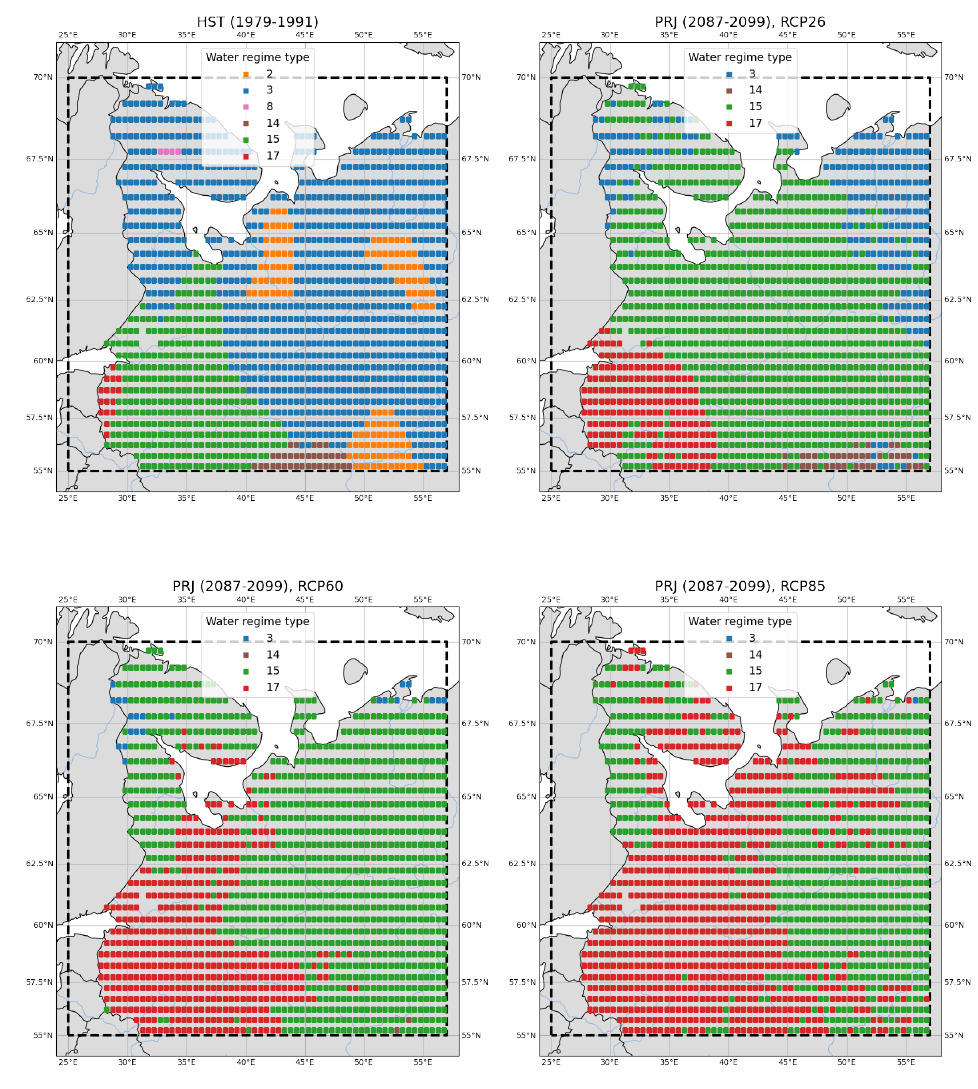
Figure 6. Historical (HST; 1979–1991) and projected (PRJ; 2087–2099) water regime types under different RCPs (RCP26, RCP60,